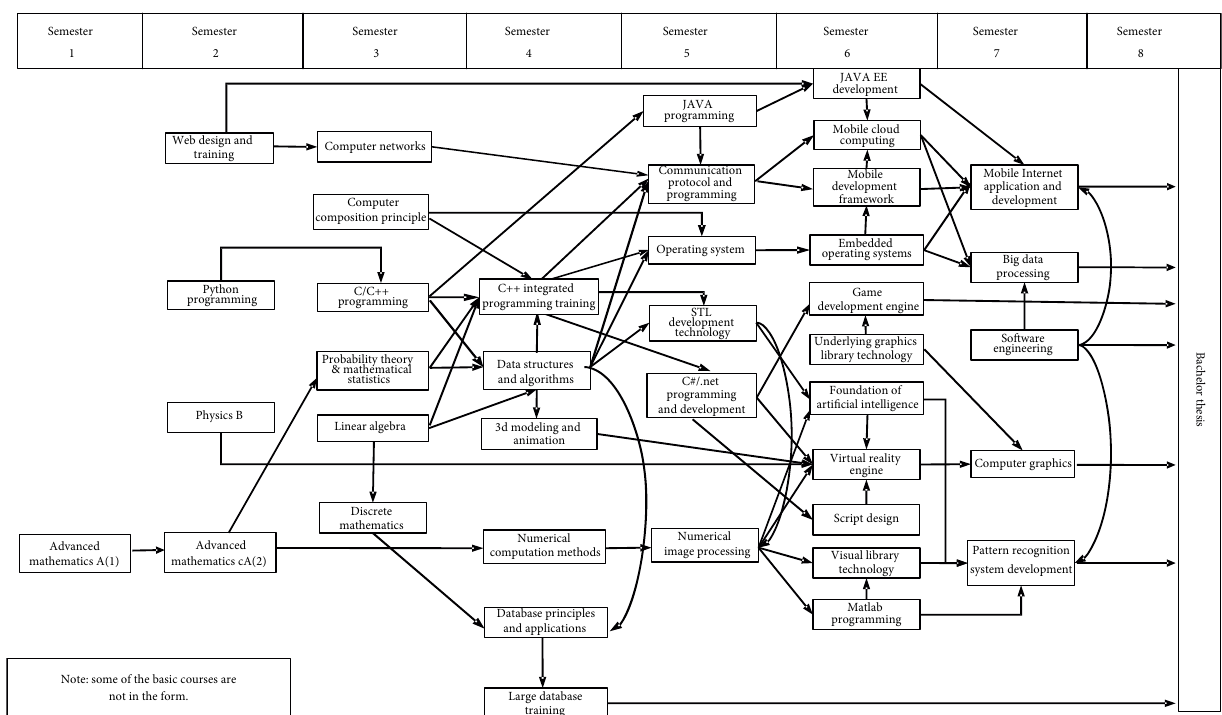
Figure 2: Course configuration flow chart of computer science and technology in Xihua University.